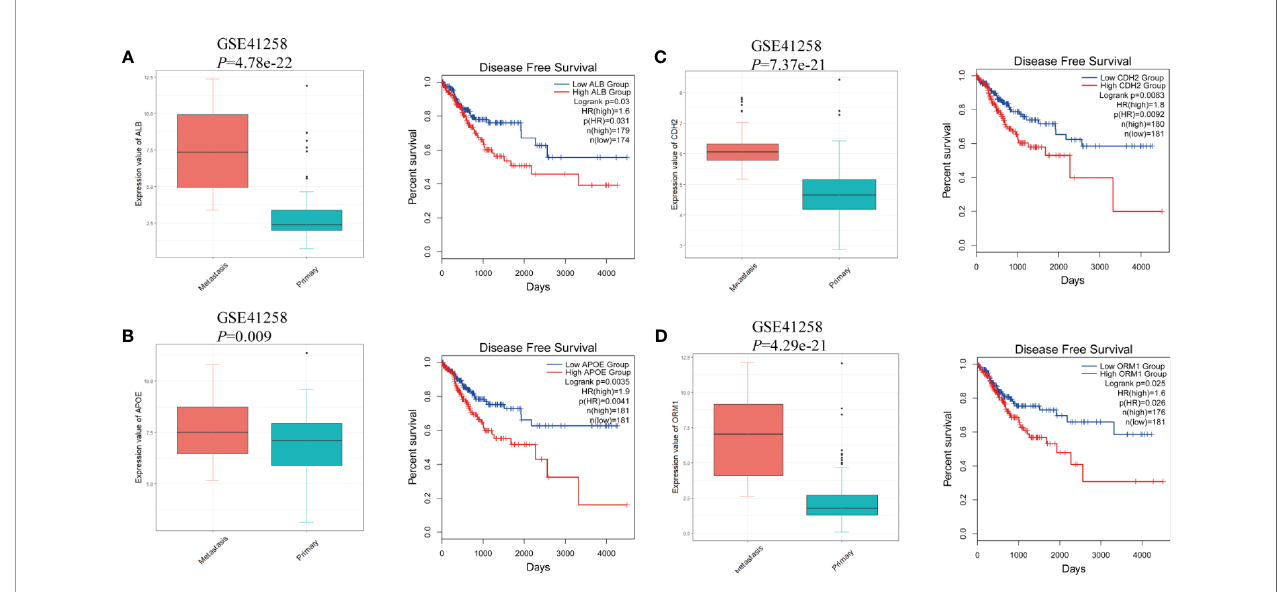
FIGURE 5 | The gene expression at different regions of colorectal cancer in GSE41258 and survival analysis from GEPIA2. (A) ALB, (B) APOE, (C) CDH2, and (D) ORM1. The statistical signi fi cance of correlations was determined using Wilcoxon rank-sum test with continuity correction and Mantel – Cox test,